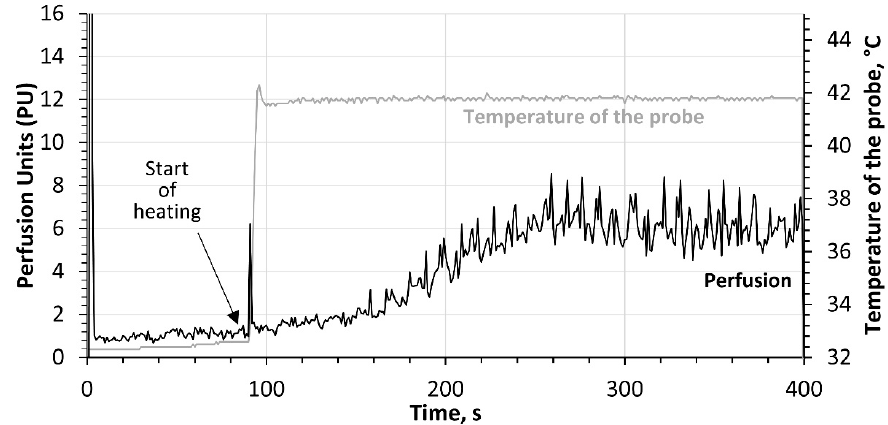
Figure 2. Example of a perfusion curve obtained by IOFF during the local heating test.